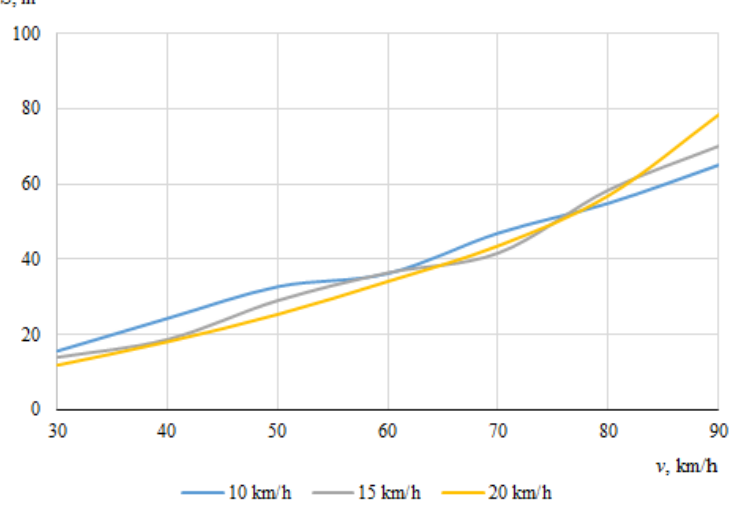
Figure 11. Throwing distances of the cyclist (impact angle 30°).